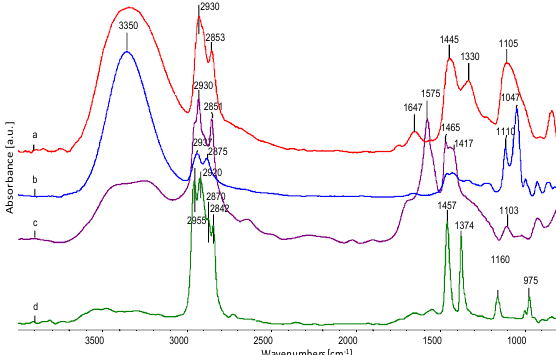
Table 5. Wavenumbers of the bands observed in the FTIR spectra of EVOH, EPC, glycerol, sodium stearate bands [11,37].